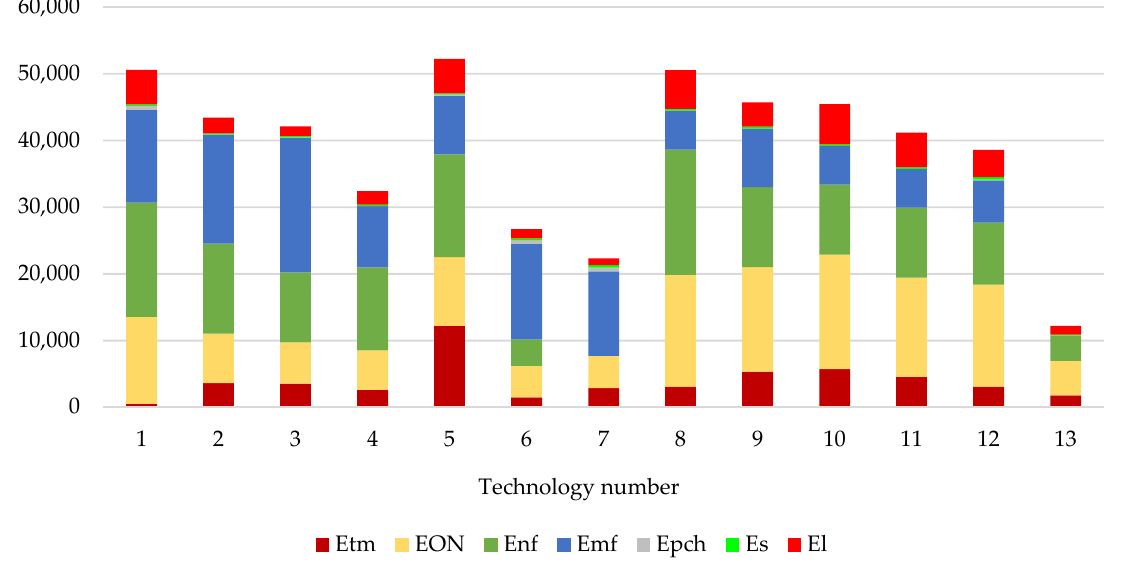
Figure 8. Energy intensity accumulated in the technologies of maize silage from individual energy inputs. [MJ · ha − 1 ]. Source: own study.